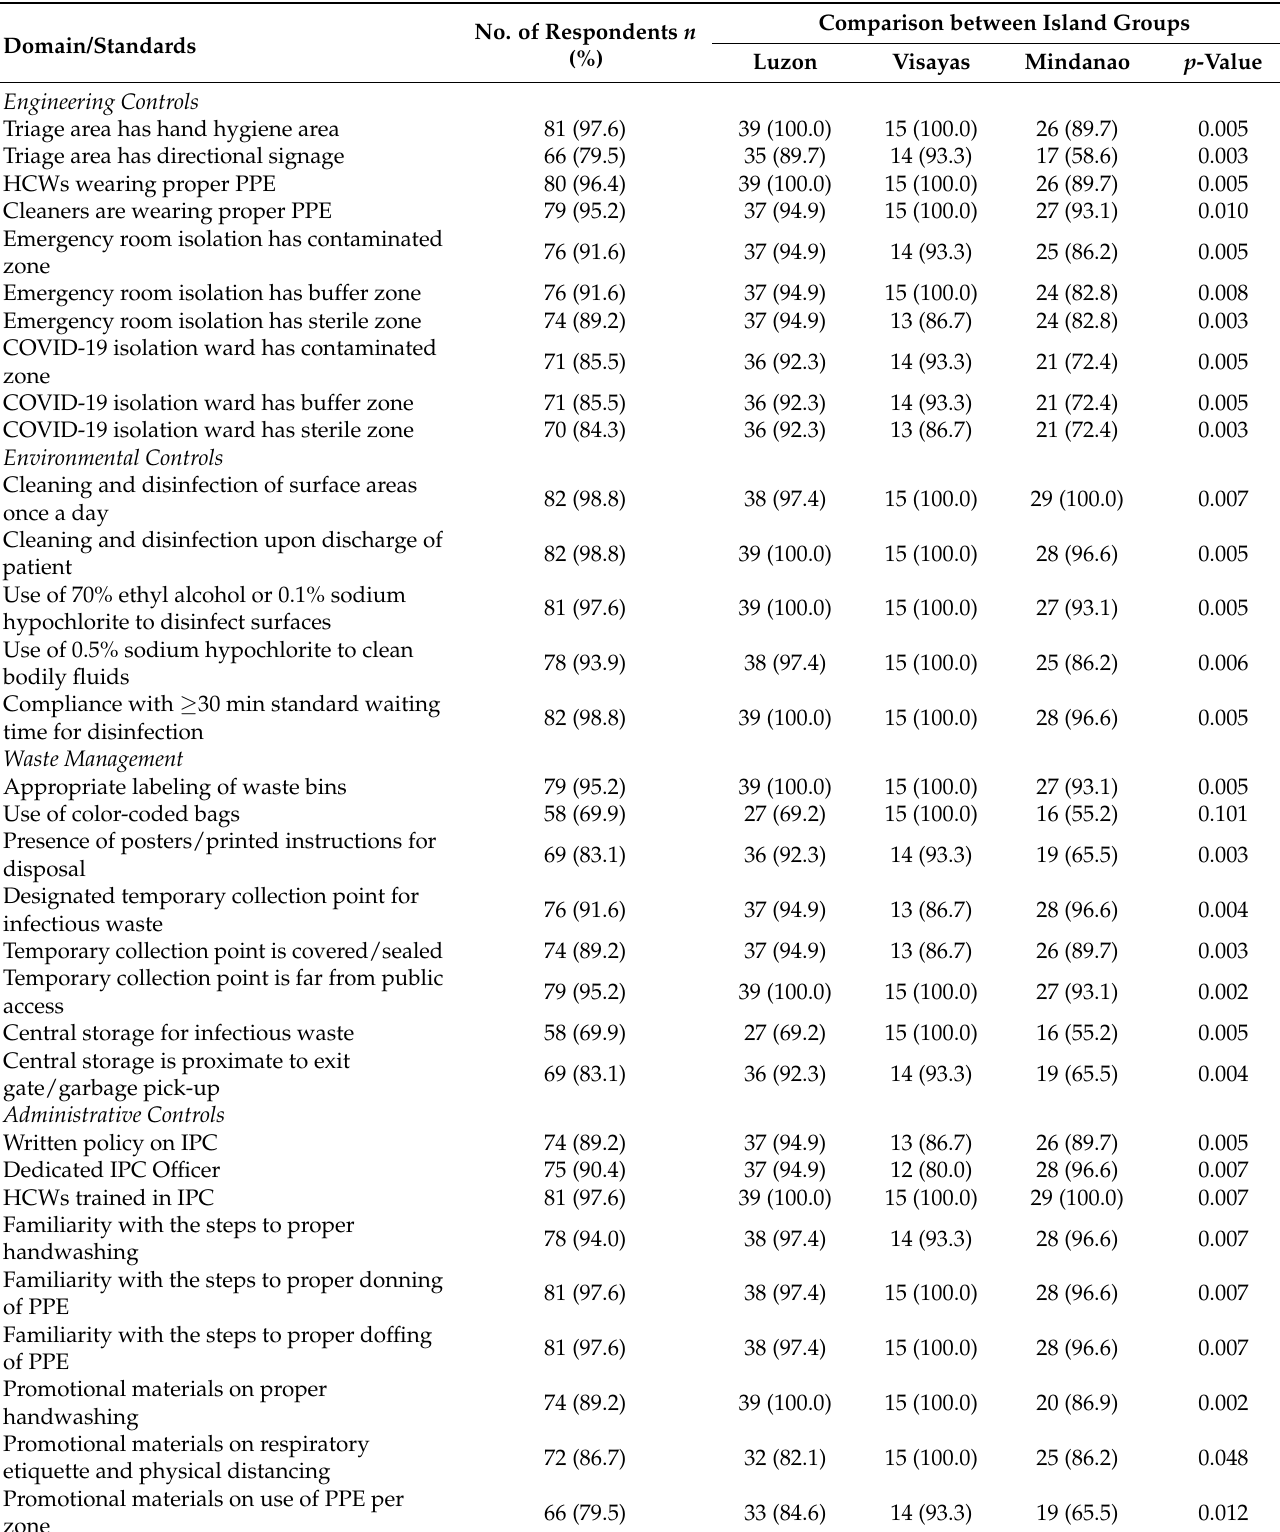
Table 2. Geographical comparison of public hospitals’ compliance with IPC standards, survey results from 83 responses in the Philippines, 4–18